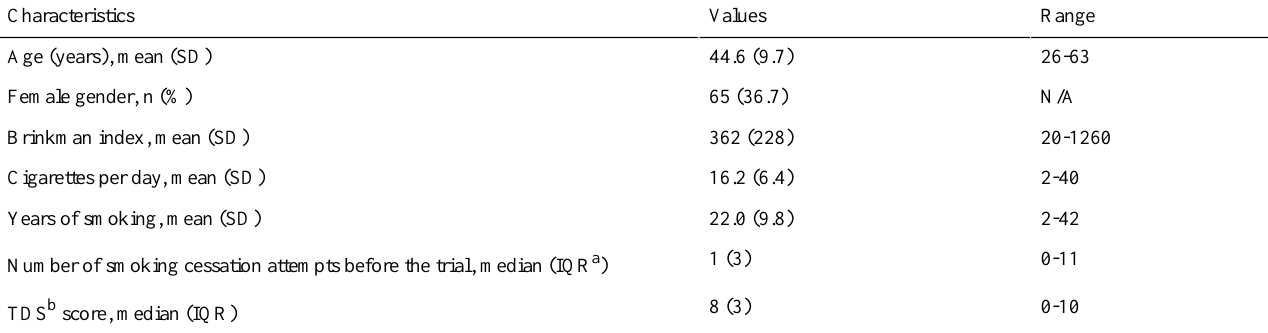
Table 1. Baseline characteristics of the 177 participants.